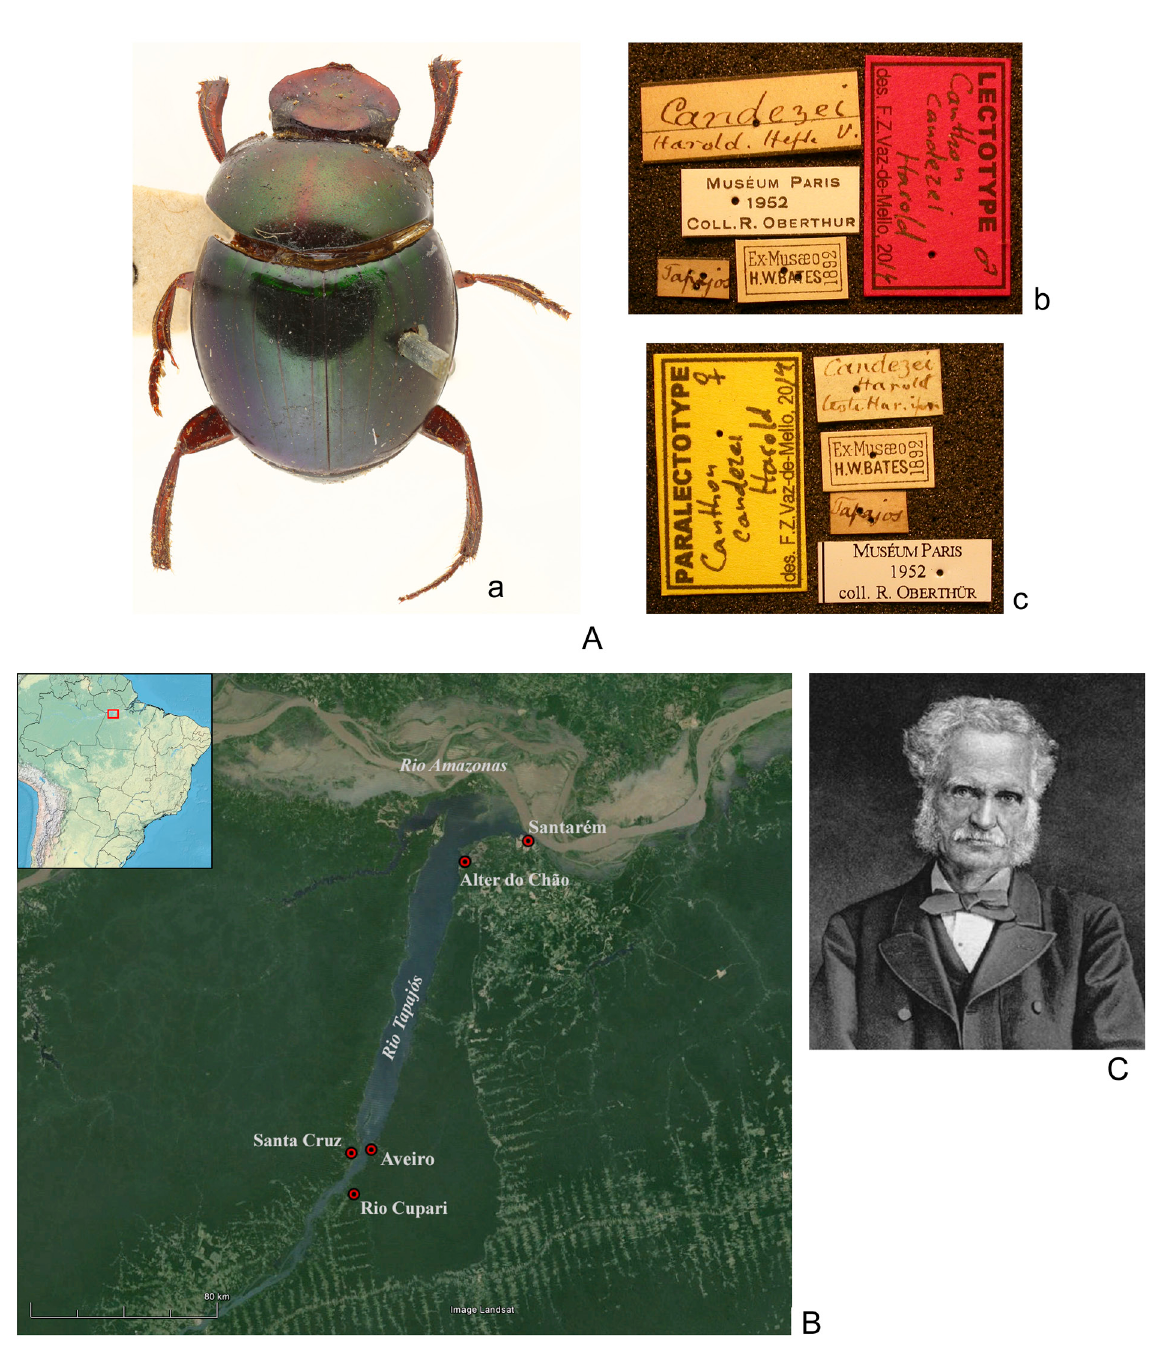
Fig. 26. Sylvicanthon candezei (Harold, 1869) type material. A . a . Lectotype. b . Labels of lectotype. c . Labels of paralectotype 3. B . The four localities where S. candezei type series may have been collected by Bates in the lower Tapajós region in 1852 (see discussion in the text). C . The English naturalist Henry Walter Bates (1825–1892), the collector of the S. candezei type series (modified from Bidau